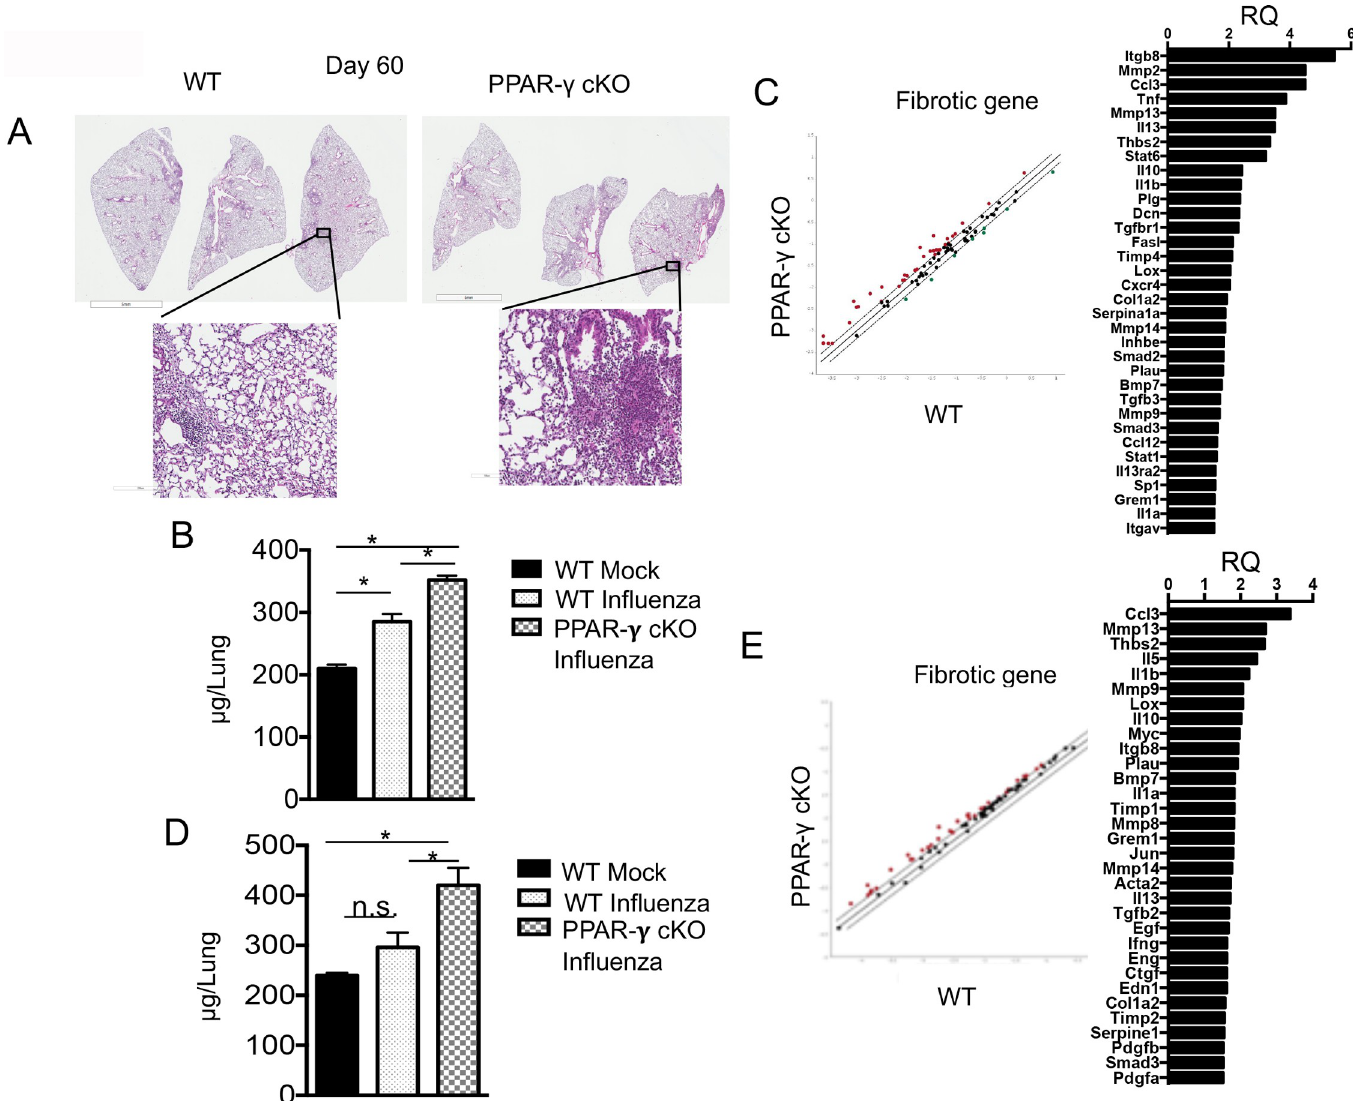
Fig 4. Myeloid PPAR- γ deficiency leads to unresolved persistent fibrosis. ( A ) WT ( Pparg fl/fl ) or PPAR- γ cKO ( Pparg Δ Lyz2 ) mice were infected with influenza virus. H&E staining of lung sections from WT or PPAR- γ cKO mice at day 60 p.i. ( B ) WT ( Pparg fl/fl ) or PPAR- γ cKO ( Pparg Δ Lyz2 ) mice were treated with saline (mock) or infected with influenza as indicated. Collagen content in the whole lungs from indicated groups mice was measured by Hydroxyproline assay at day 60 p.i. ( C ) WT ( Pparg fl/fl ) or PPAR- γ cKO ( Pparg Δ Lyz2 ) mice were infected with influenza virus. Lung fibrotic genes expression was measured by QIAGEN Fibrosis RT 2 RT-PCR array at day 60 p.i. Red dots, genes upregulated in PPAR- γ cKO lungs, green dots, genes downregulated in PPAR- γ cKO lungs. ( D ) WT ( Pparg fl/fl ) or PPAR- γ cKO ( Pparg Δ Lyz2 ) mice were treated with saline (mock) or infected with influenza virus as indicated. Collagen content in the lungs from indicated groups mice was measured by Hydroxyproline assay at day 90 p.i. ( E ) WT ( Pparg fl/fl ) or PPAR- γ cKO ( Pparg Δ Lyz2 ) mice were infected with influenza virus. Lung fibrotic genes expression was measured by QIAGEN Fibrosis RT 2 RT-PCR array at day 90 p.i. Red dots, genes upregulated in PPAR- γ cKO lungs, green dots, genes downregulated in PPAR- γ cKO lungs. Data are representative of two independent experiments (3–5 mice/group/experiment). Statistical differences are indicated. � , P < 0.05 (one-way